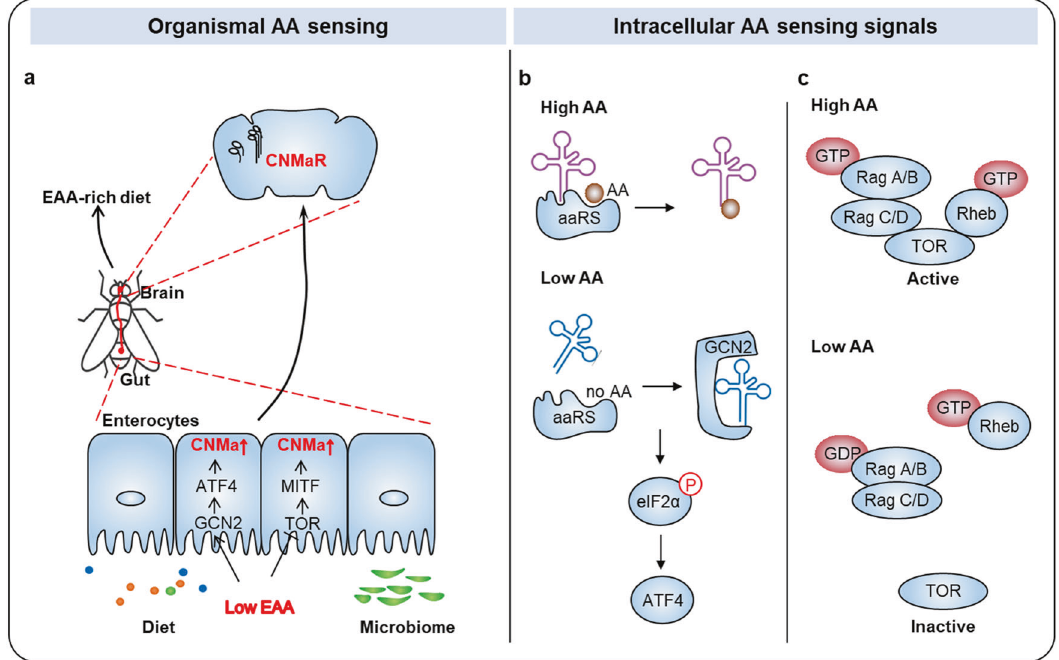
Fig. 1 Amino acid-sensing machineries . a During the process of amino acid-driven food selection, the gut communicates with the brain through neurons, secreted hormones and neurotransmitters, and the gut microbiome. In this study, the authors fi nd that gut enterocytes detect and respond to protein limitation through upregulating CNMa expression and communicating with CNMaR-expressing neurons in the brain, leading to the compensatory appetite for L-EAAs. AA, amino acids. b GCN2, an indirect amino acid sensor, could detect any low-level amino acid through binding to the uncharged cognate tRNA, which leads to a conformational change of GCN2. This structural alteration activates the kinase activity of GCN2, culminating in inhibitory phosphorylation of eukaryotic translation initiator factor 2 α (eIF2 α ) and the increased transcription of starvation-relevant genes, such as activating transcription factor 4 (ATF4). aaRS, aminoacyl transfer RNA synthetase. c TOR is positively regulated by the GTP-charged form of the Ras-like GTPase Rheb (Rheb-GTP) and heterodimeric Rag GTPase. Amino